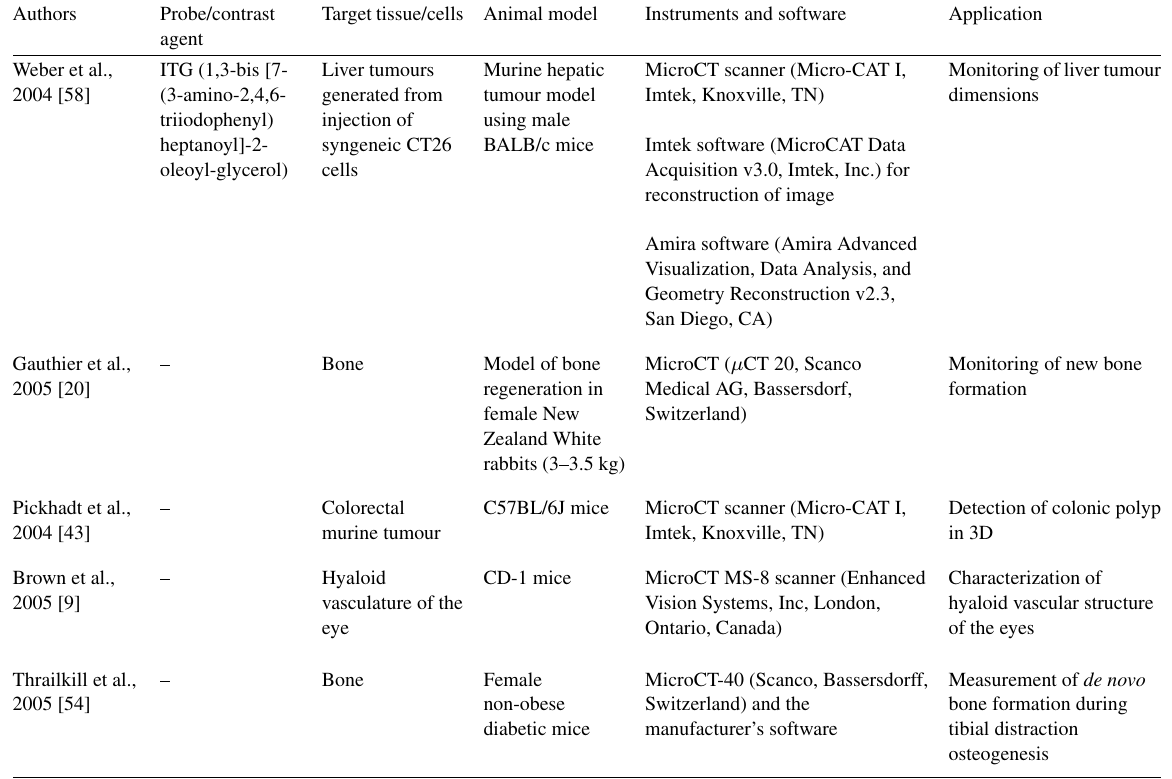
Summary of CT application and